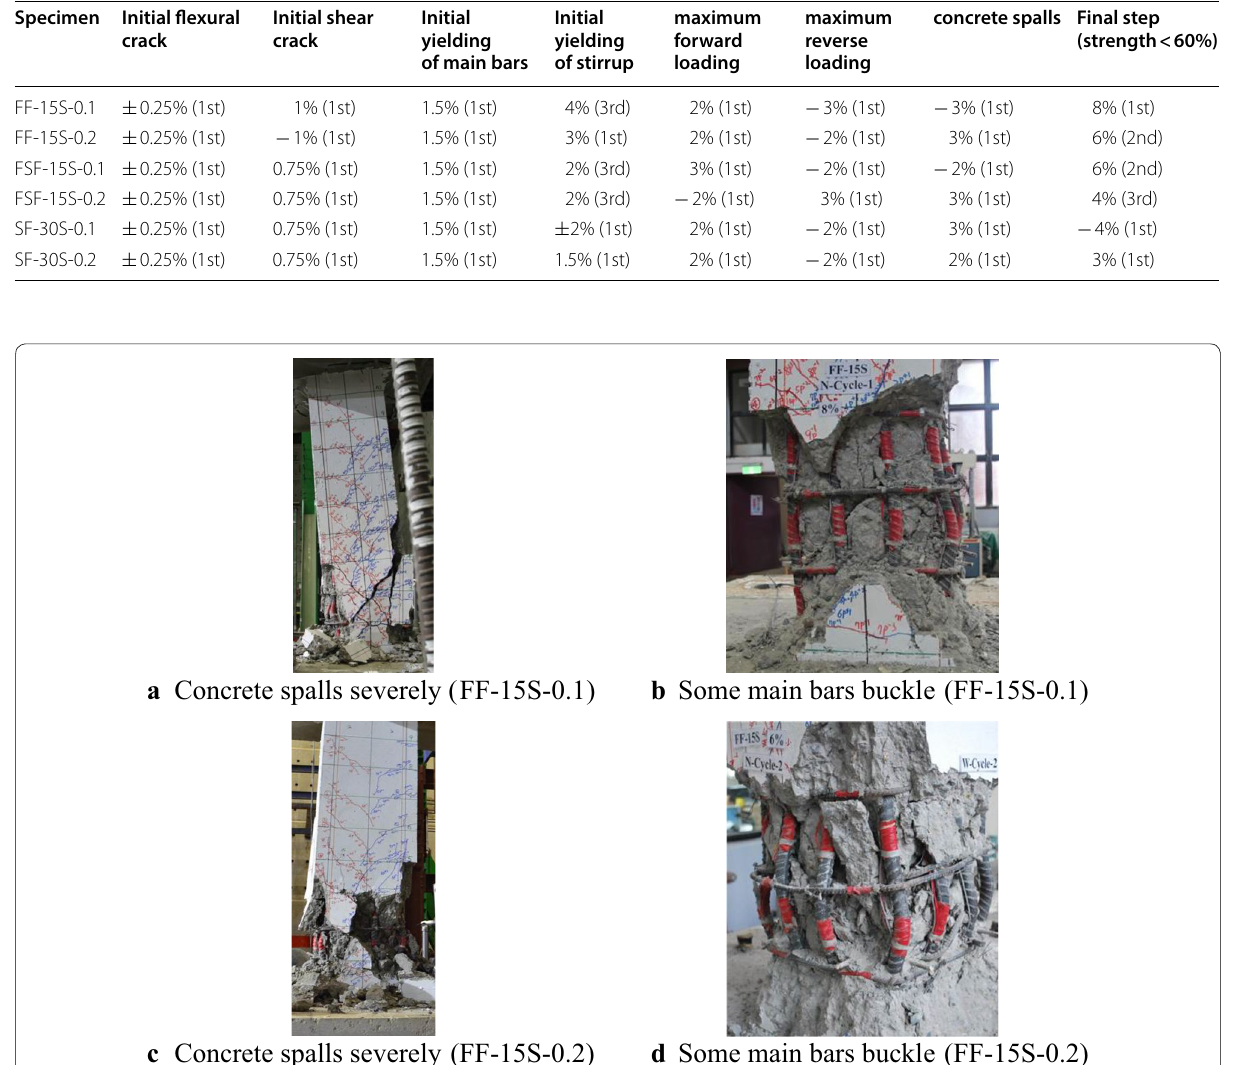
Fig. 9 Specimens of FF‑15S‑0.1 and